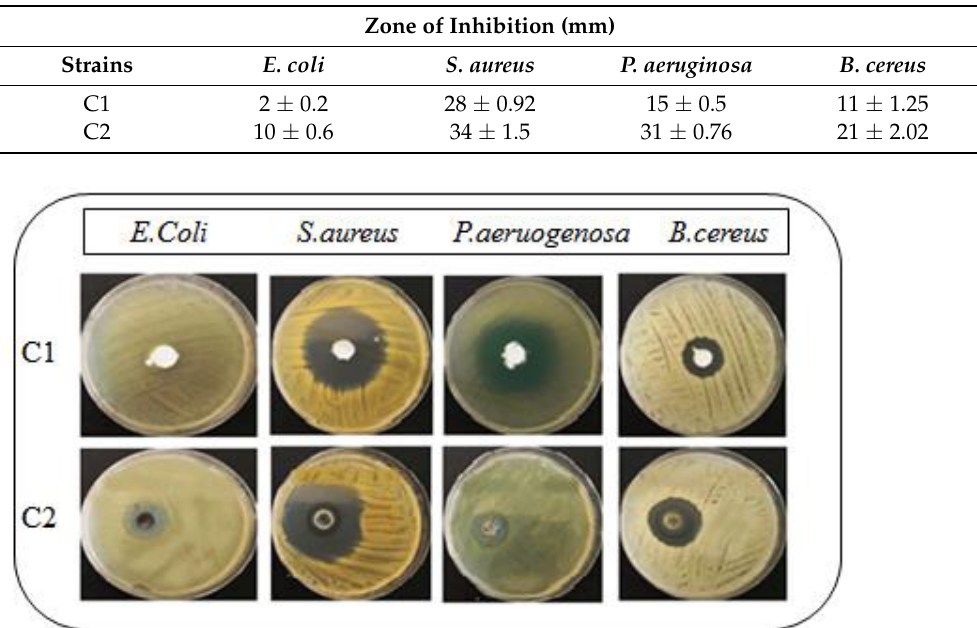
Table 5. Zone of inhibition for different bacterial strains.